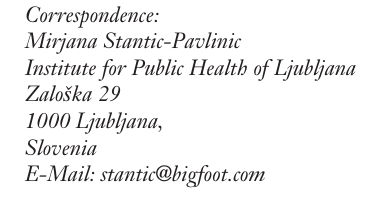
Level of interferon alpha (pg/ml) in the sera of patients during the course of treatment. Patients Mode of treatment